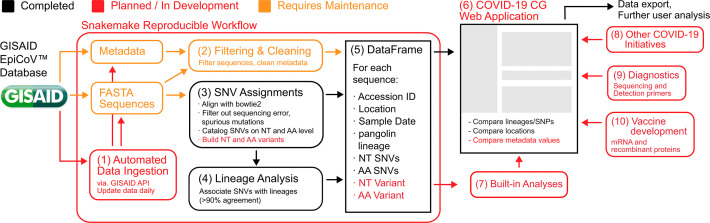
COVID-19 CG computational workflow.(1) Sequences and metadata are automatically downloaded and ‘ingested’ on a daily basis. Data for https://covidcg.org is downloaded from a custom GISAID endpoint, but can be configured for any data provider, for example, GenBank (see Methods for details). (2) Based on best practices, we filter out sequences on NextStrain’s exclusion list, non-human SARS-CoV-2 genomes, <29,700,700 nt, or with >5% ambiguous base calls (van Dorp et al., 2020b). (3) Single-nucleotide variations (SNVs) at the nucleotide and amino acid level are determined by aligning (via bowtie2) each sequence to the WIV04 reference, a high quality December 2019 genome recommended by GISAID; NextStrain uses the 100% identical Wuhan-Hu-1 (Langmead et al., 2009). Importantly, spurious SNVs and probable sequencing errors are filtered out prior to downstream analysis. (4) Viral lineages (defined by the pangolin tool) and clades are provided by GISAID. In accordance with pangolin, SNVs present in >90% of sequences within each lineage are assigned as lineage-defining SNVs. (5) The curated data and metadata, SNVs, and lineage-assigned SNVs are associated with their respective sequence identifier and compiled into a compact data set. (6) These data are uploaded onto the COVID-19 CG web application. (7) New analyses will be built into the COVID-19 CG application throughout the course of the pandemic. (8–10) Features and modules that integrate knowledge from other COVID-19 initiatives are continuously incorporated into COVID-19 CG.